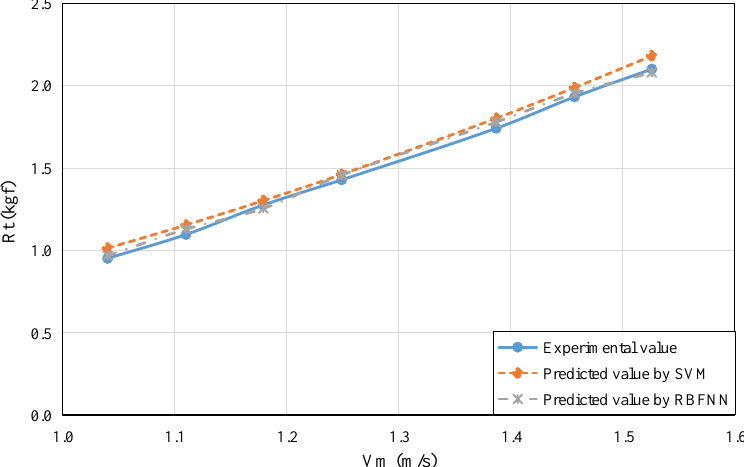
Figure 12. The ship resistance prediction results of the SVM and RBFNN models at the draft = 0.136 m.